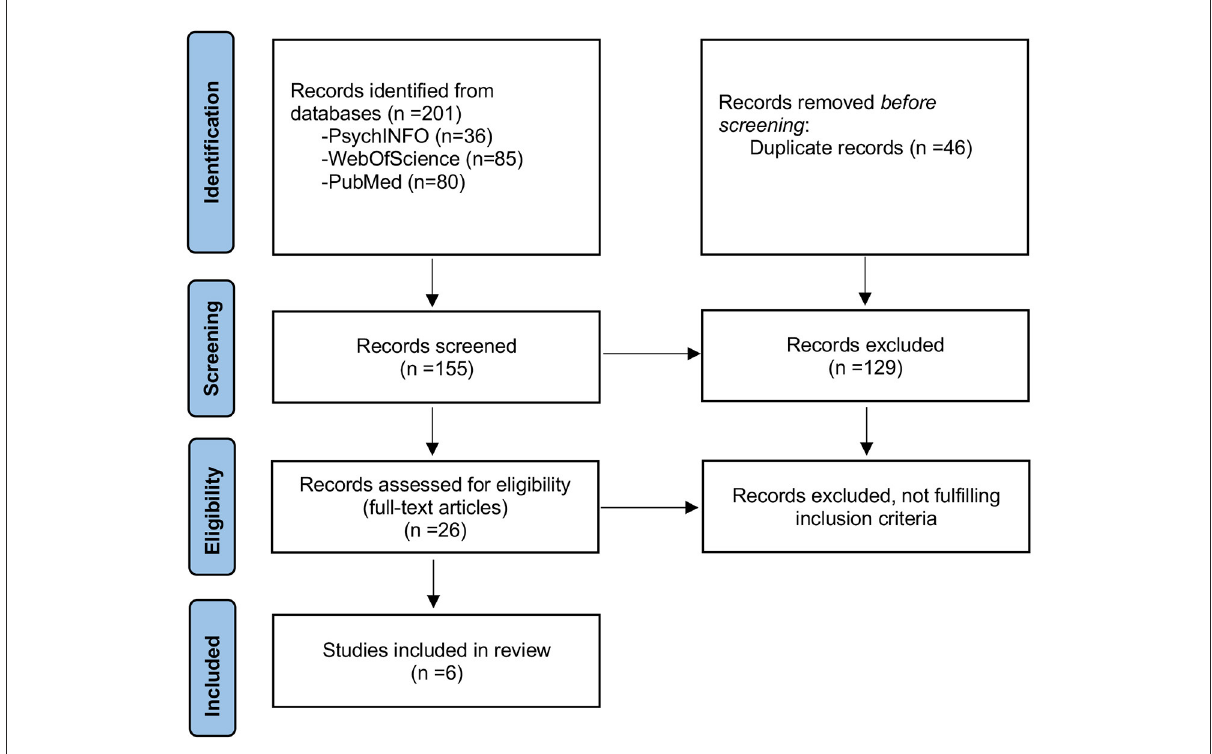
FIGURE1 Flowchart of selected